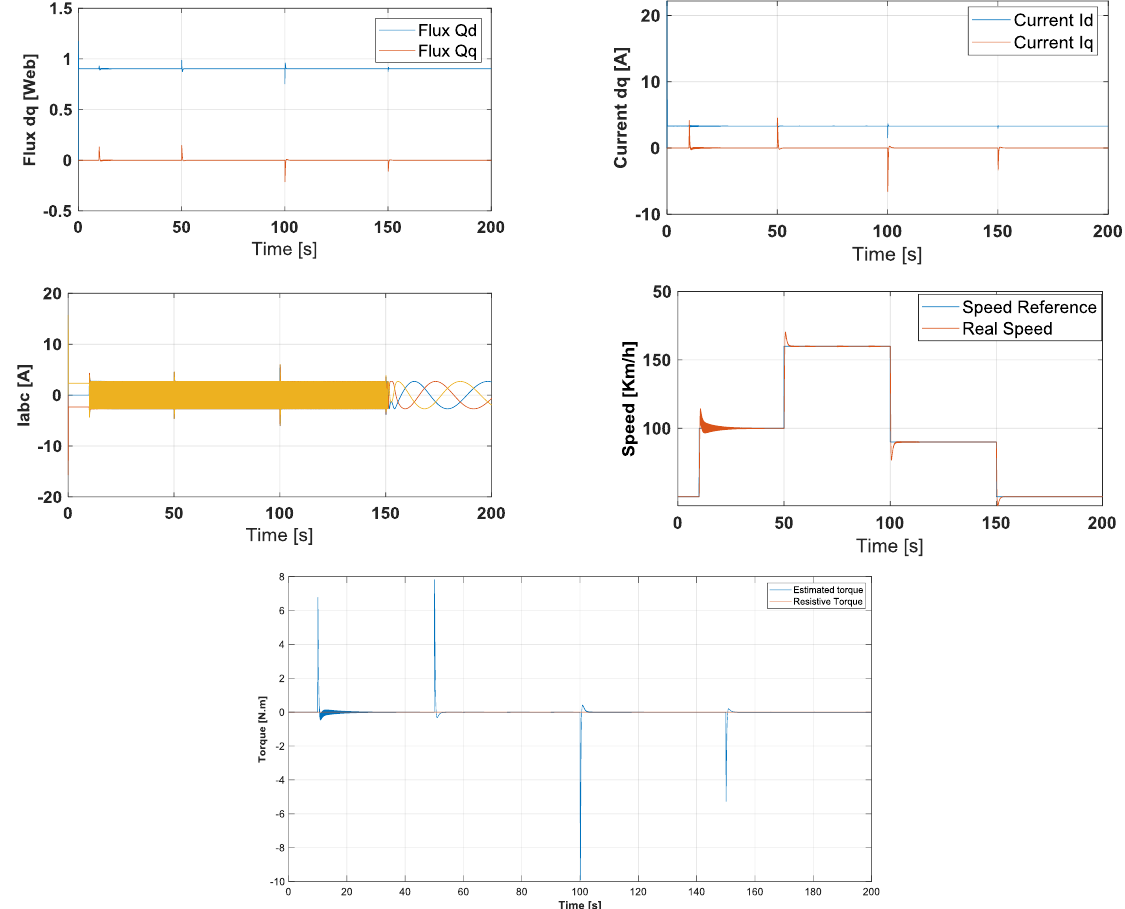
Figure 10. Response of the quantities (Flux, Currents, speed, and electromagnetic torque) of the MAS in the case of classical vector